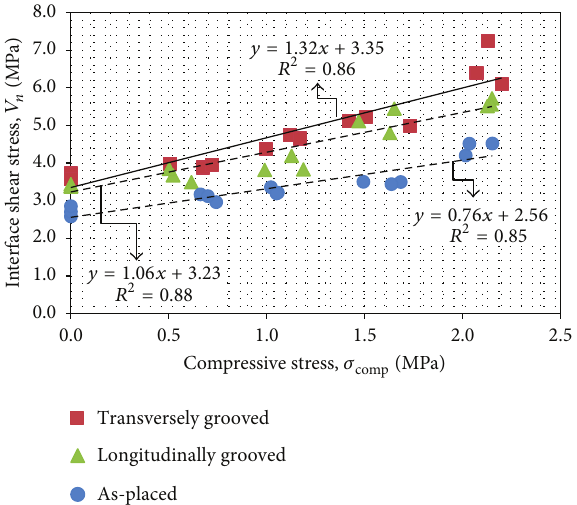
Figure 8: Effect of compressive stress on the shear strength of interface with different substrate surface conditions.